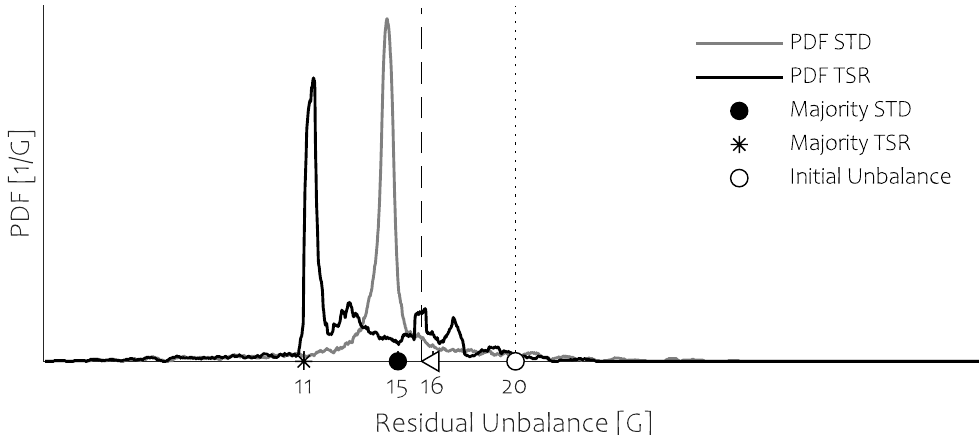
Figure 5. Probability density function of the residual unbalance for an initial unbalance G20 (dashed line), standard (grey) and TSR (black)